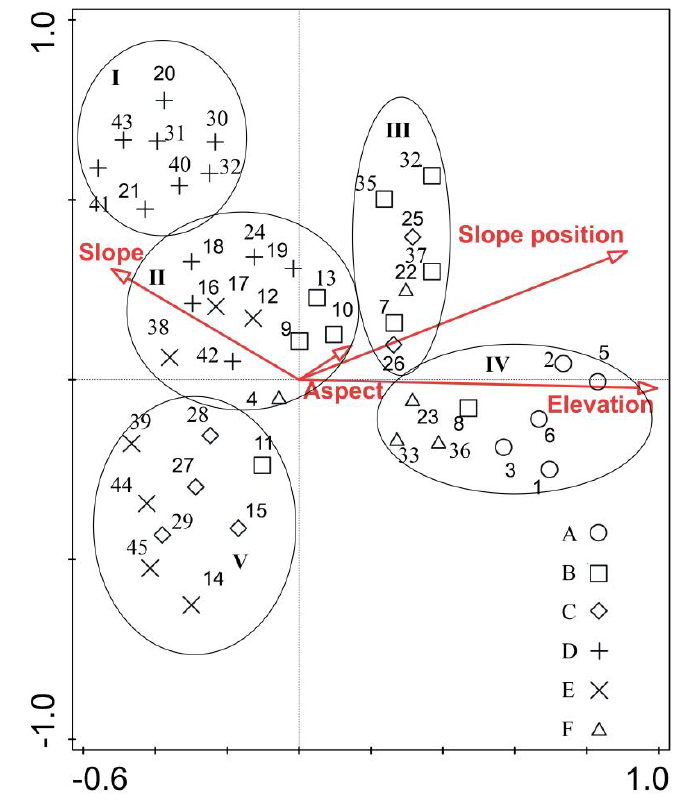
Figure 7. The DCCA analysis of vegetation quadrats and topographic factors (1–45: the serial number of vegetation quadrats; A–E: vegetation community; I–V: ecotope.)